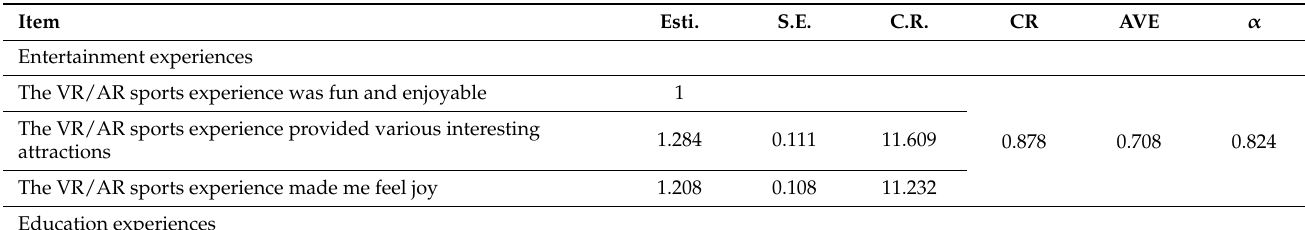
Table 4. Results of confirmatory factor analysis and reliability